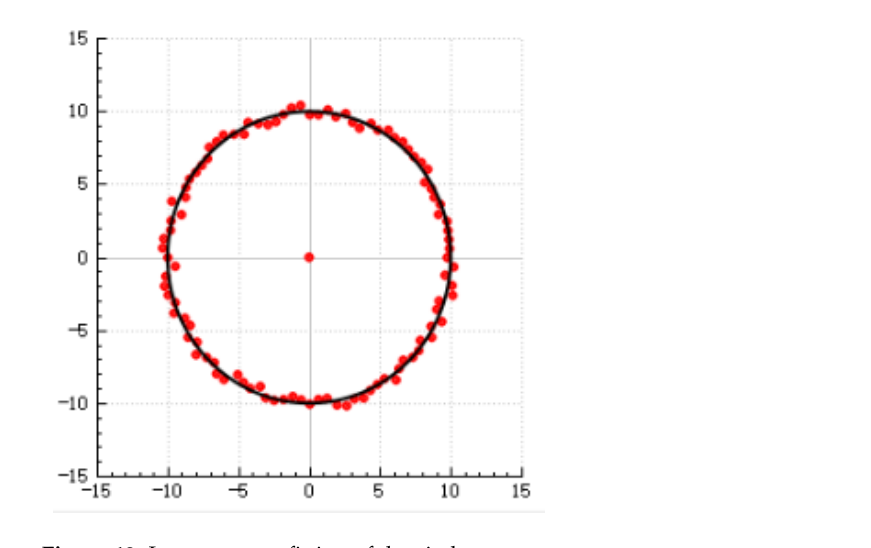
Figure 12. Least squares fitting of the circle center.